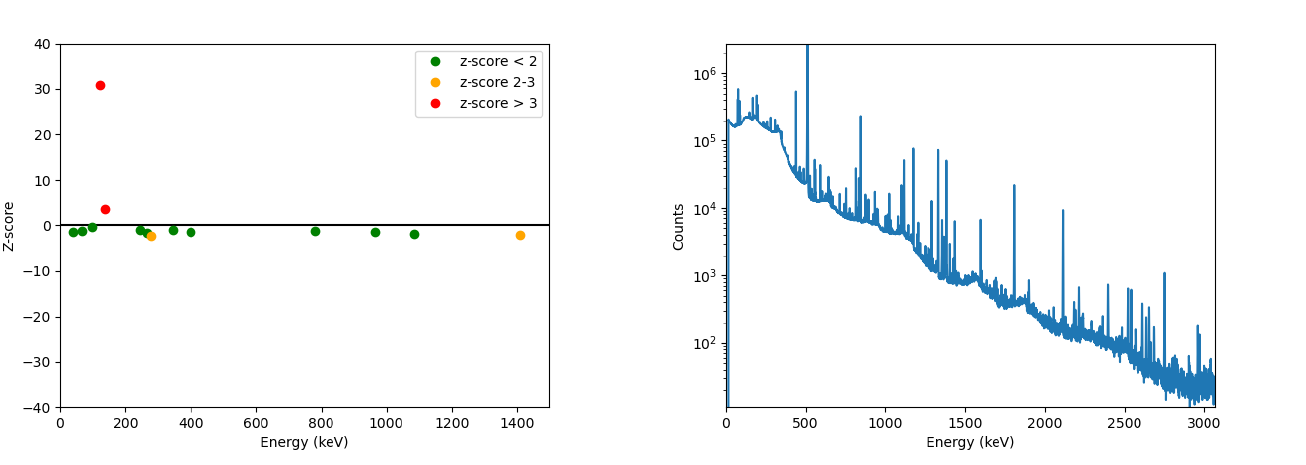
Figure 3, The peak area recovery z-score for an analysis of an interference Figure 4, the reactor coolant spectrum. where a contributing interference is missing. There were 278 peaks found in the spectrum, with a large T ABLE 2 C OMMON CAUSES FOR INCONSISTENCIES AND THEIR SIGNATURES IN interference containing 139 peaks and 30 radionuclides. The THE PEAK AREA RECOVERY RATIO . peak area recovery ratios for the interference are shown in Figure 5. There are 22 outlier peaks where the absolute value of the z-score is larger than 3, 19 of these have a z-score larger than 3 and 3 had a ratio below negative 3. All the peaks that were identified as outliers were investigated for common reasons according to Table 2.